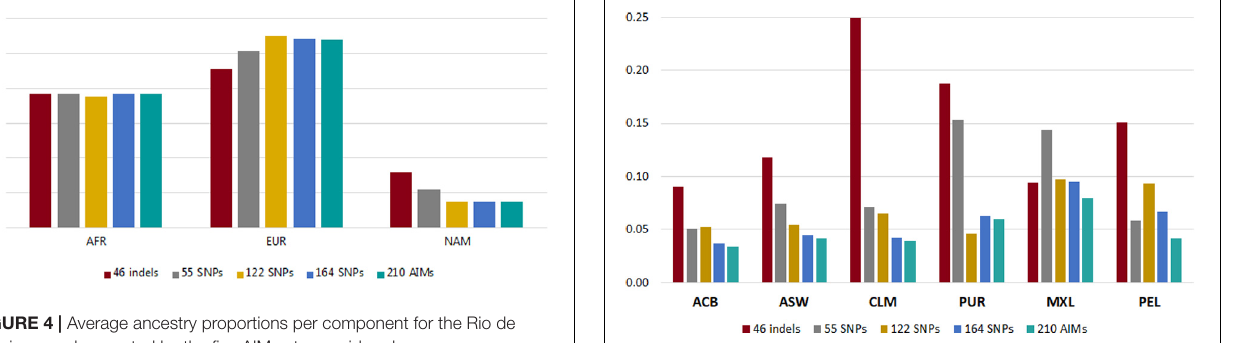
Frontiers in Genetics |